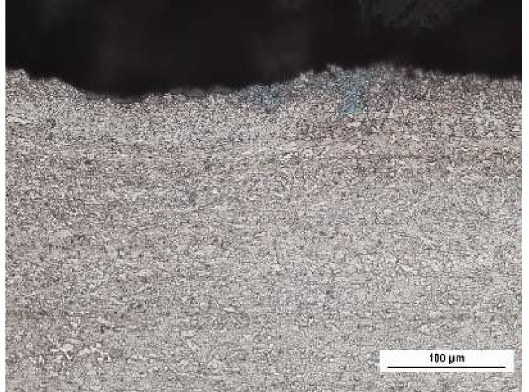
Figure 6. Optical images of surface of MC700